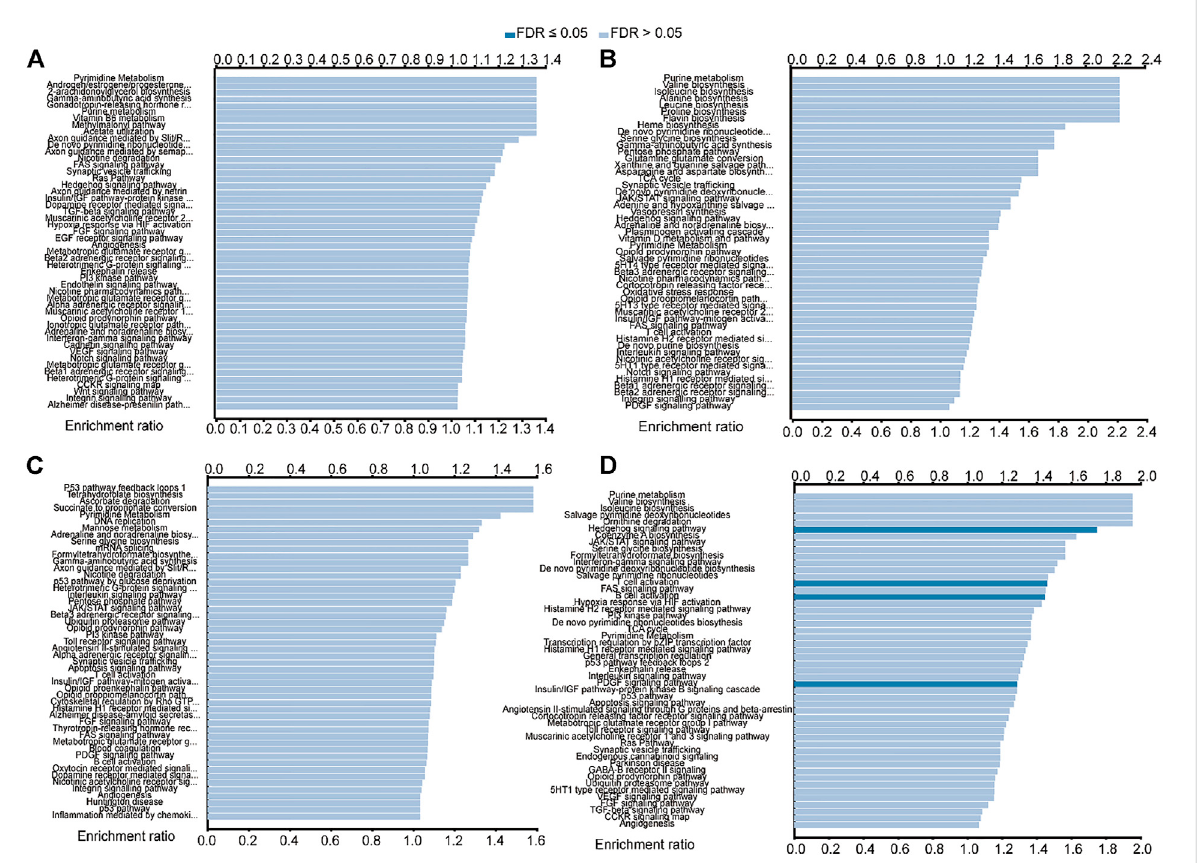
FIGURE 8 Functional enrichmentanalysis of BAK1 ,NLRP1,CHMP7, andRIPK1inheadandnecksquamouscellcarcinoma